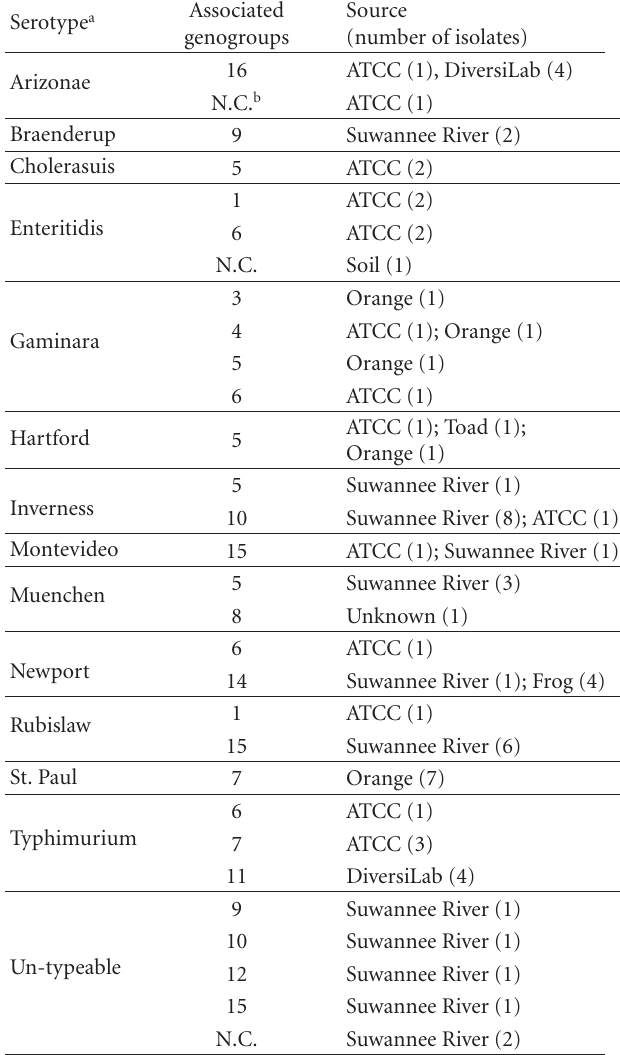
Table 6: Relationship of serotype to